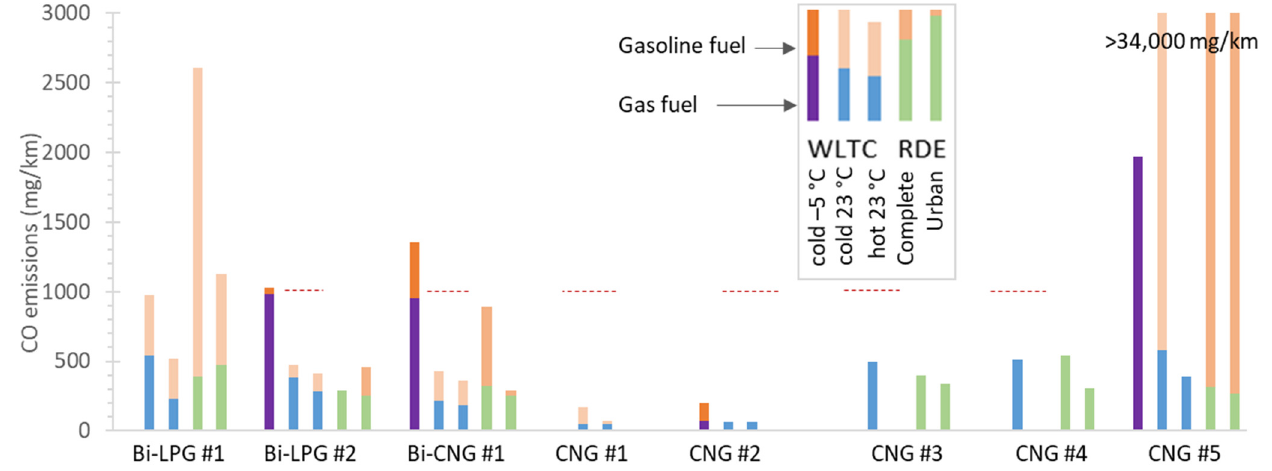
Figure 3. CO emissions. Dotted lines give the applicable Euro 6 emission limits in the laboratory. The limit of Bi-LPG #1 is 1000 mg/km for the NEDC, and of CNG #5 is 2270 mg/km for the